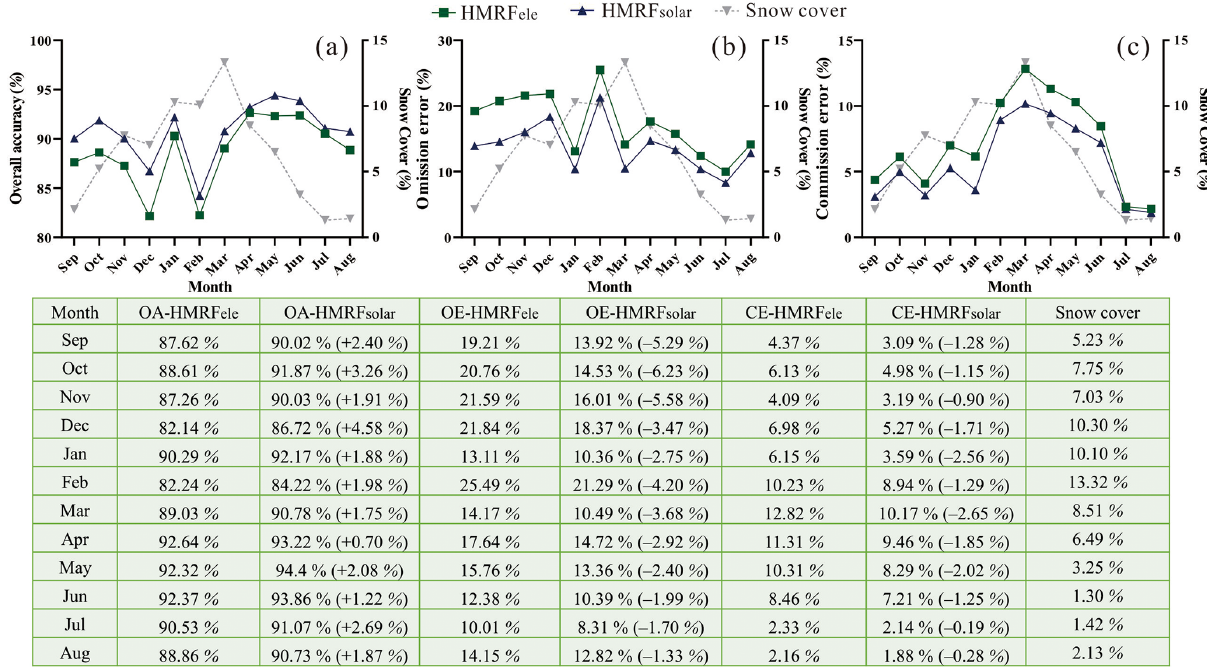
Figure 4. Temporal variations in OA (overall accuracy) (a) , OE (omission error) (b) , and CE (commission error) (c) of HMRF ele - and HMRF solar -based snow products from